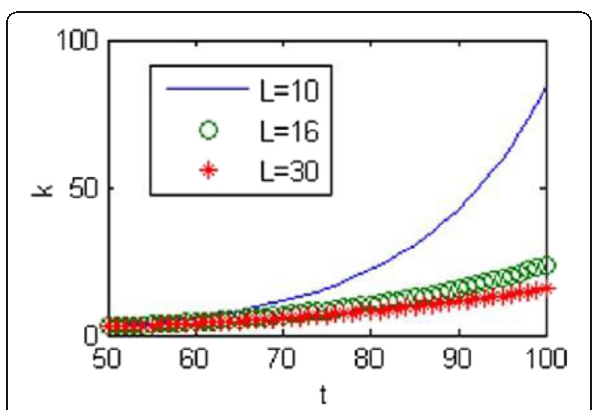
Fig. 4 The degree distribution with various energy distributions